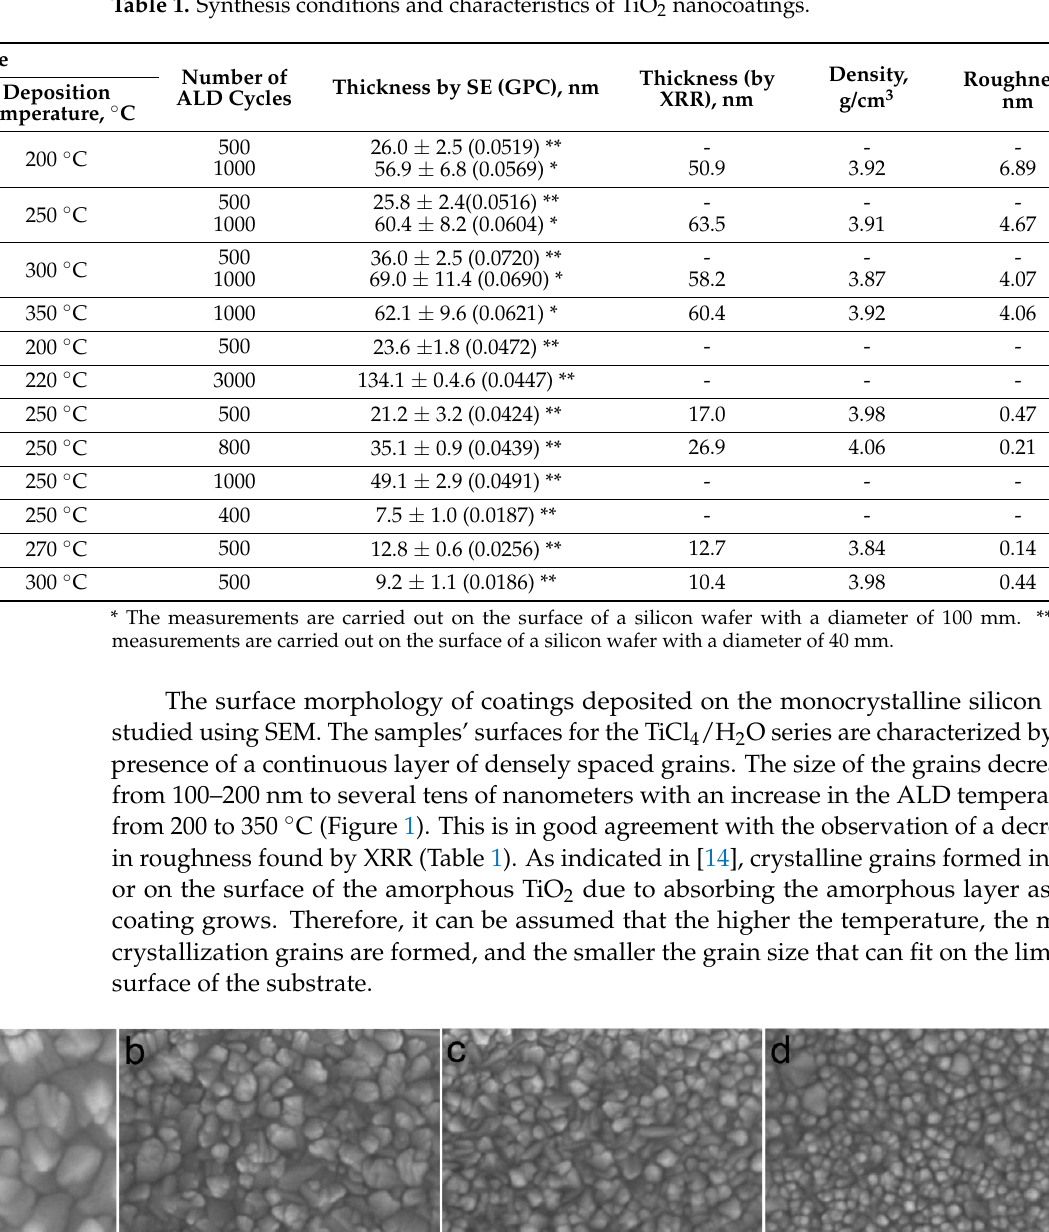
Table 1. Synthesis conditions and characteristics of TiO 2 nanocoatings.